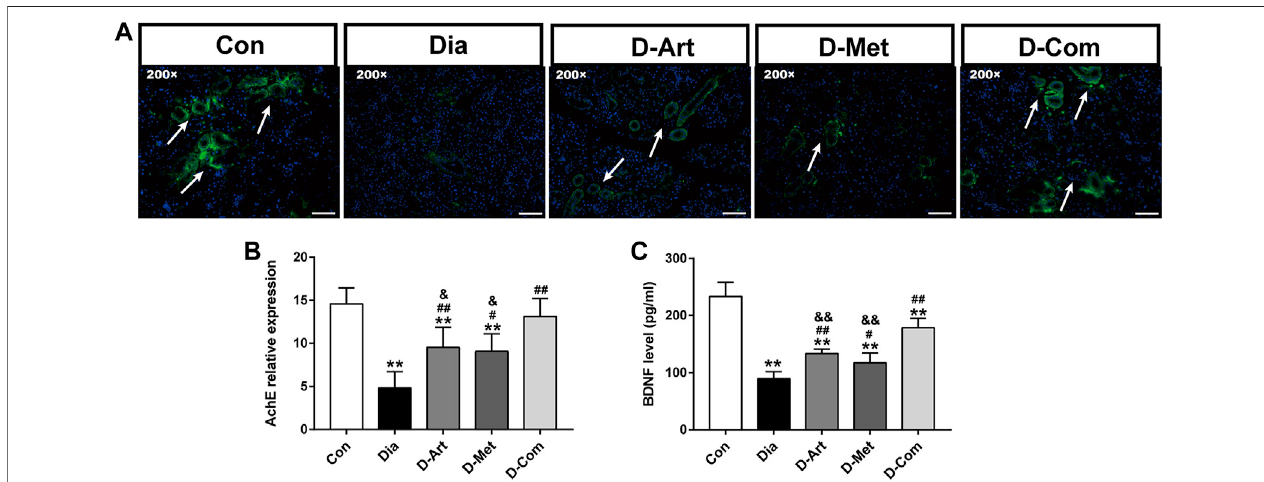
FIGURE 6 | ART or Met alone and ART/Met combination preserved peripheral parasympathetic innervation of SGs in the T2DM rats. (A) Immuno fl uorescence of AChEinSMGsofeachgroup,scalebar (cid:1) 50 μ m(200 × ). (B) LevelofAChEexpressioninSMGsofeachgroup. (C) ELISAanalysisofBDNFinSMGsofeachgroup(5rats per group). Data are expressed as the mean ± SD. ** p < 0.01 versus Con group; # p < 0.05 and ## p < 0.01 versus Dia group; & p < 0.05 and && p < 0.01 versus D-Com group. Con, Normal control group; Dia, Untreated diabetic group; D-Art, ART-treated diabetic group; D-Met, Met-treated diabetic group; D-Com, ART/Met co- treated diabetic